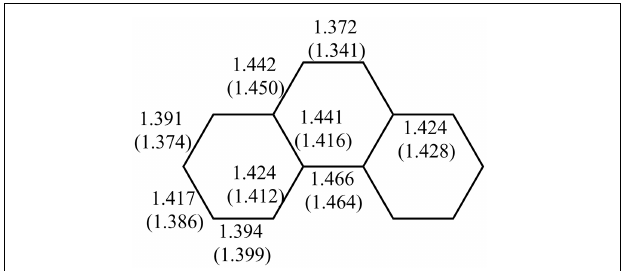
Figure 1 | BLYP/6-31G(d) and experimental (in parentheses) (Kay et al., 1971) bond lengths (in Å) of phenanthrene.